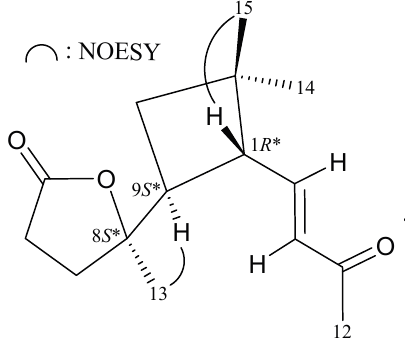
Figure 2. Selective key NOESY correlations for 1